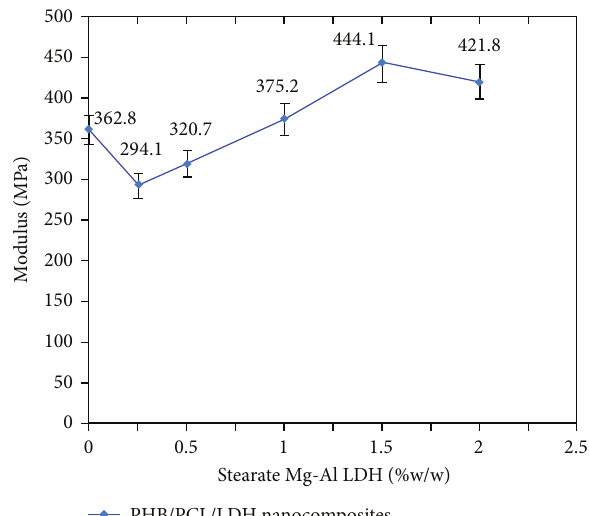
Figure 7: Modulus of PHB/PCL/stearate Mg-Al LDH nanocompos- ites with 0.25, 0.5, 1, 1.5, and 2wt% stearate Mg-Al LDH content.